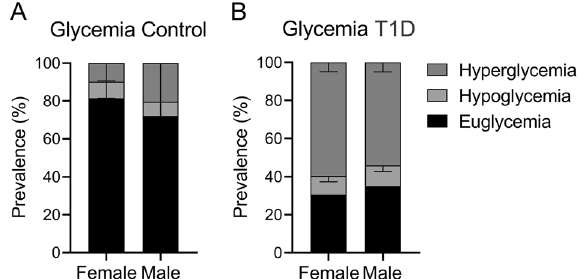
Figure 1. Prevalence of time spent in different glycemic states (hyperglycemic, hypoglycemic and euglycemic period). In females and males with diagnosis of T1D and Control group. One-way ANOVA, following Holm- Sidak posthoc.